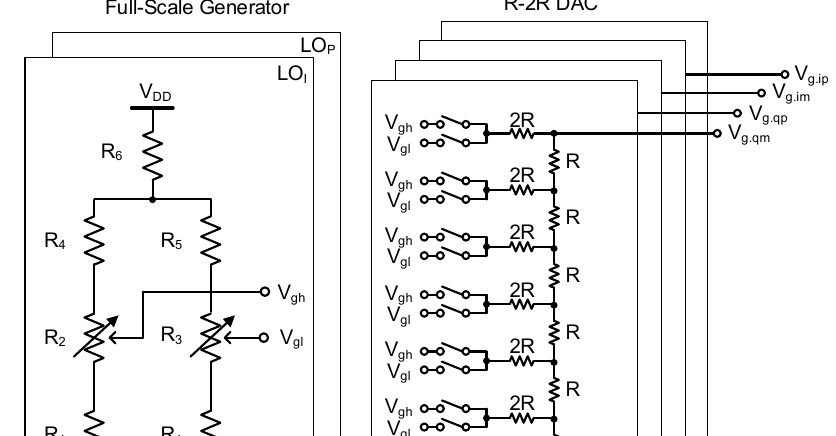
Figure 4. Baseband amplifier schematic.